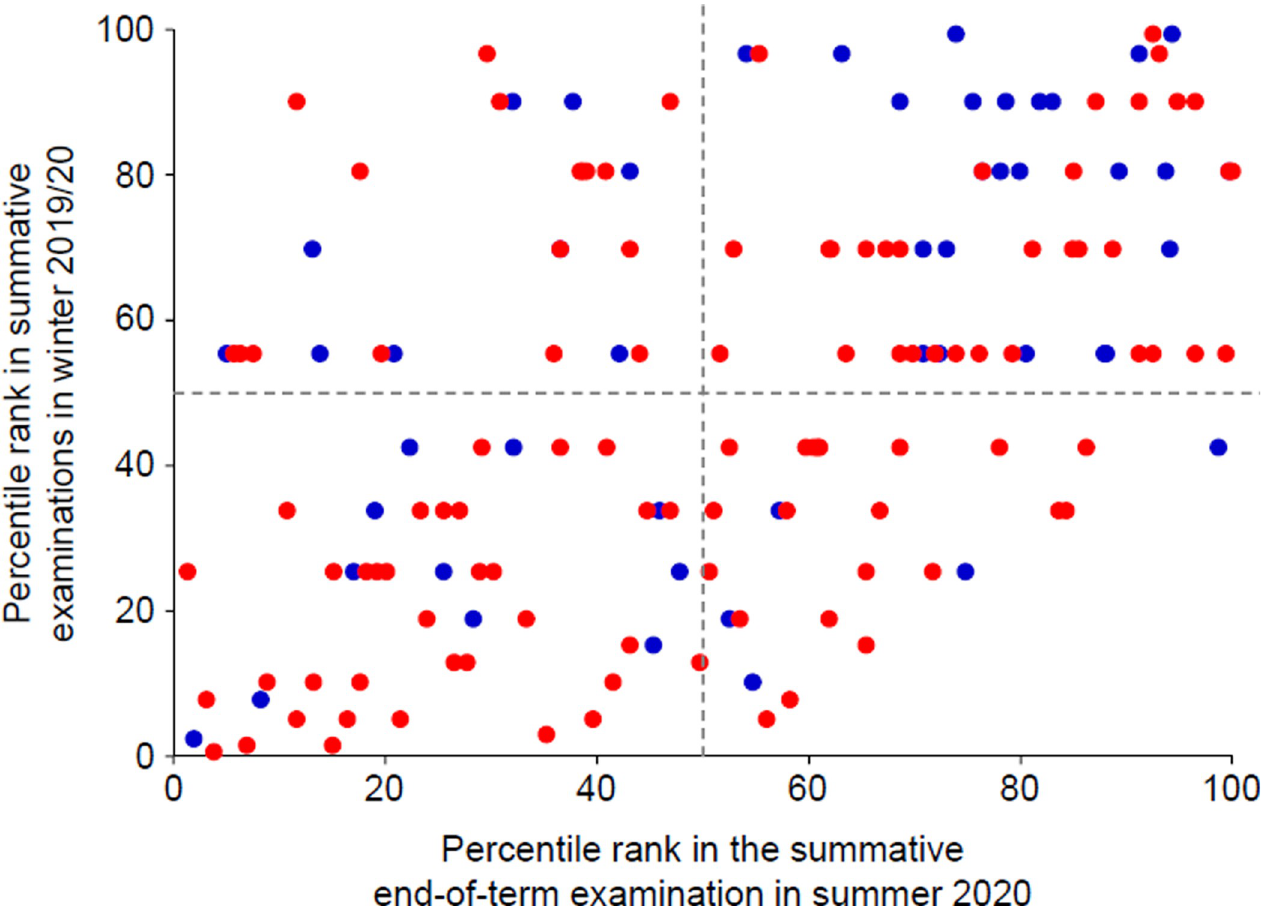
Fig 2. Scatterplot with percentile ranks in summative exams of the previous term vs. the summative end-of-term module in summer 2020. Red circles, female students; blue circles, male students. Splitting performance in both terms at the 50 th percentile yielded four distinct student groups: two groups in which students stayed in either the lower (group I: n = 46; 29.7%) or the upper half (group II: n = 57; 36.8%) of their cohort, one group in which performance had deteriorated (group III: n = 26; 16.8%) and one with an improvement of performance (group IV: n = 26; 16.8%). The proportion of female students (red circles) was non-significantly higher in the deterioration group compared to the improvement group (80.8% vs. 65.4%; p =